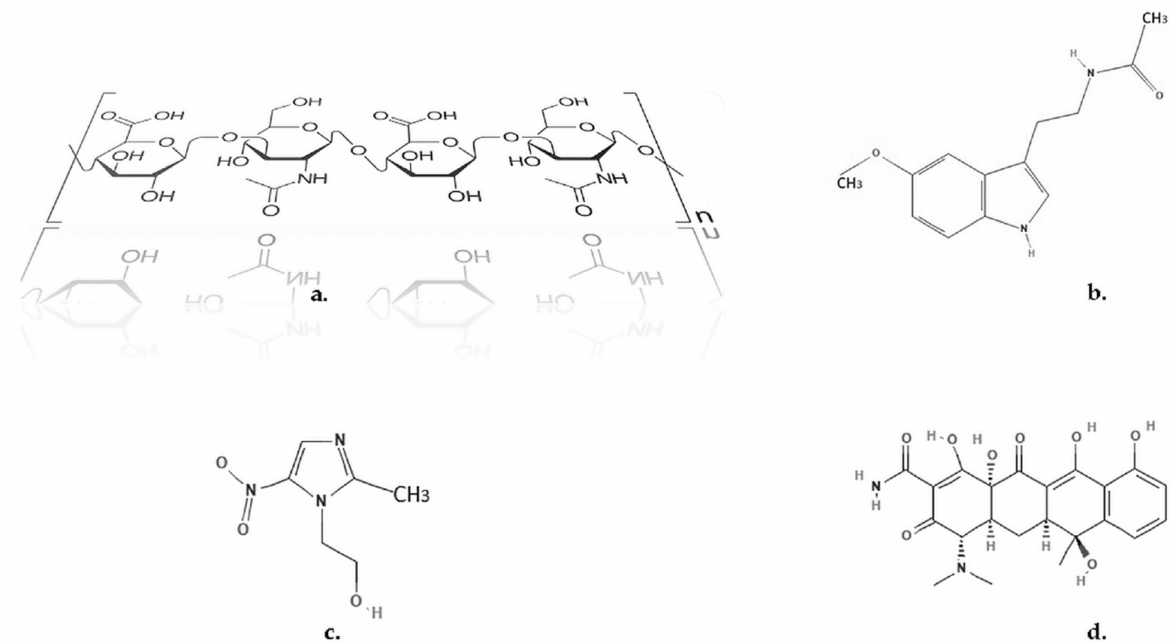
Figure 1. Chemical structures. ( a ) HA; ( b ) MEL; ( c ) MZ; ( d ) T